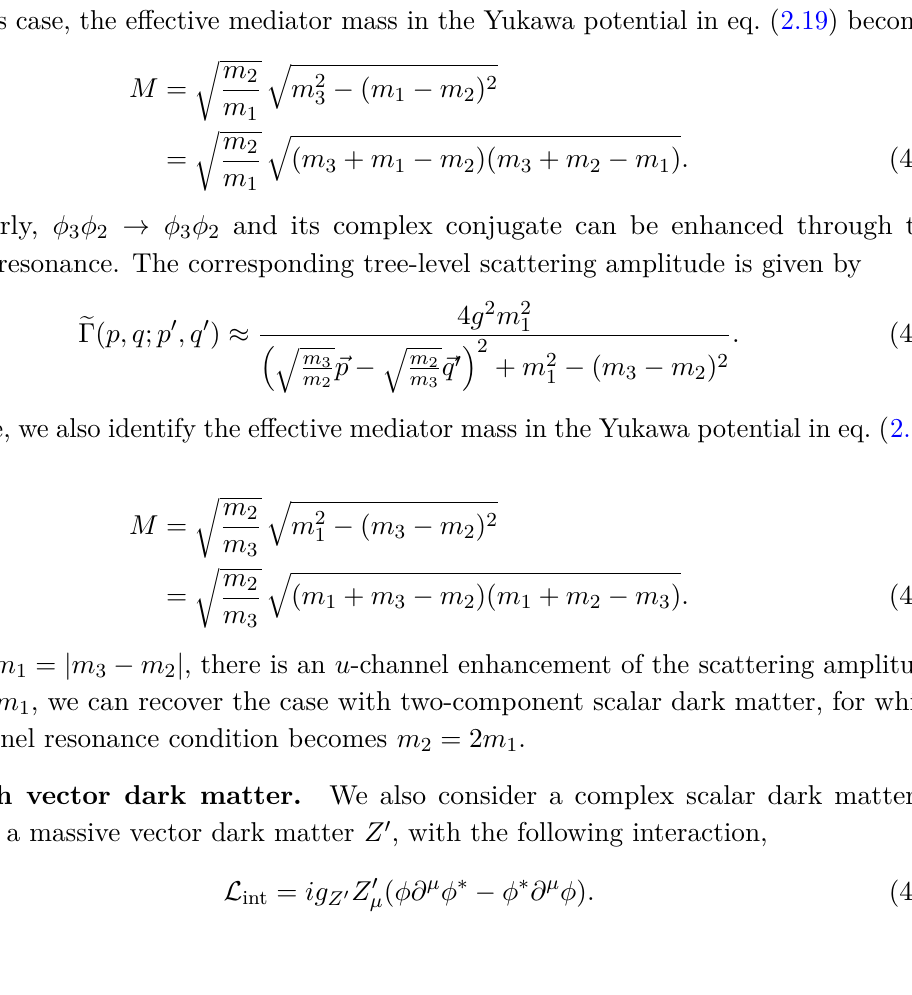
Table 1 . Tree-level amplitudes for elastic co-scattering for multi-component dark matter with minimal couplings, divided by the u -channel propagator. When there are two signs, the upper (lower) sign denotes the fermion (anti-fermion) scattering. “NA” implies that the processes are disallowed or velocity-suppressed. For vector ( X )-vector ( X 3 ) scattering, we consider gauge bosons in a non-abelian gauge theory in the dark sector. Here, X is a complex gauge boson and X 3 is a real gauge boson. We remark that the overall positive sign implies an attractive Yukawa potential for the s -wave